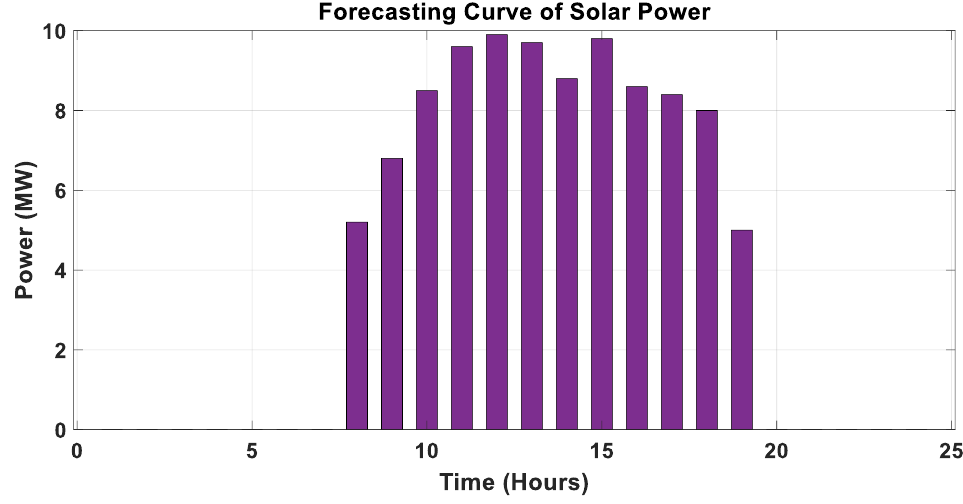
Figure 6. Forecasting curve of solar PV modules.